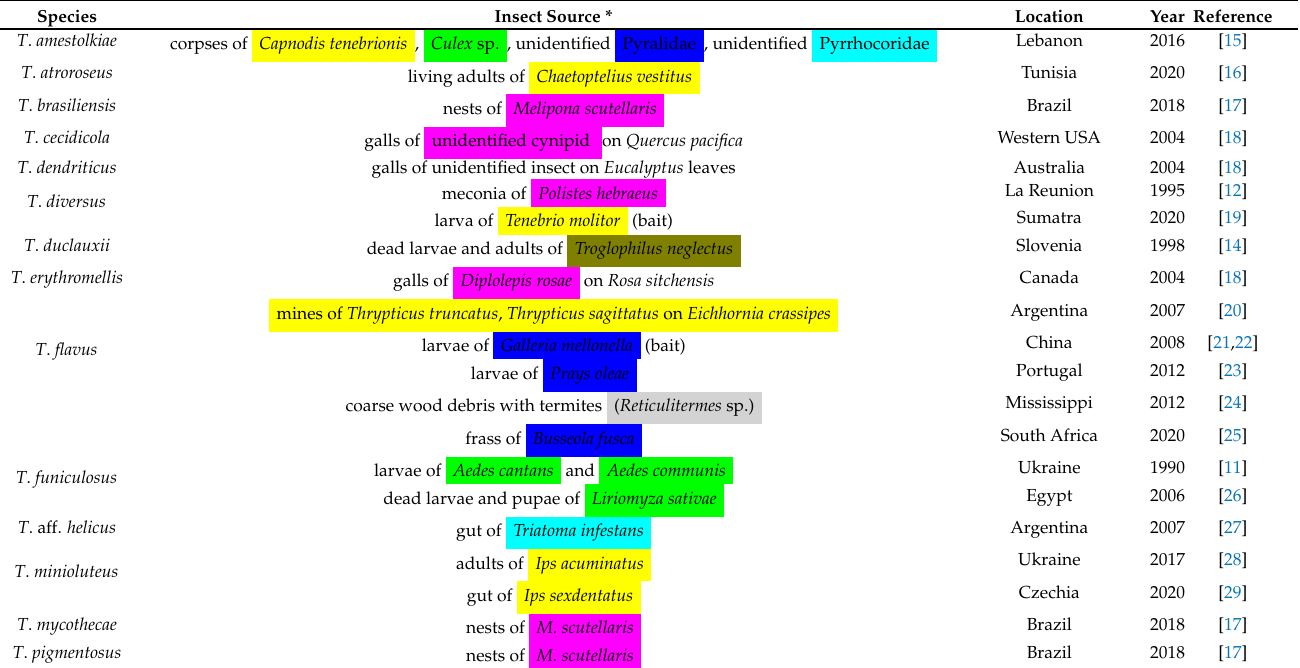
Table 1. Occurrence of Talaromyces species found in association with